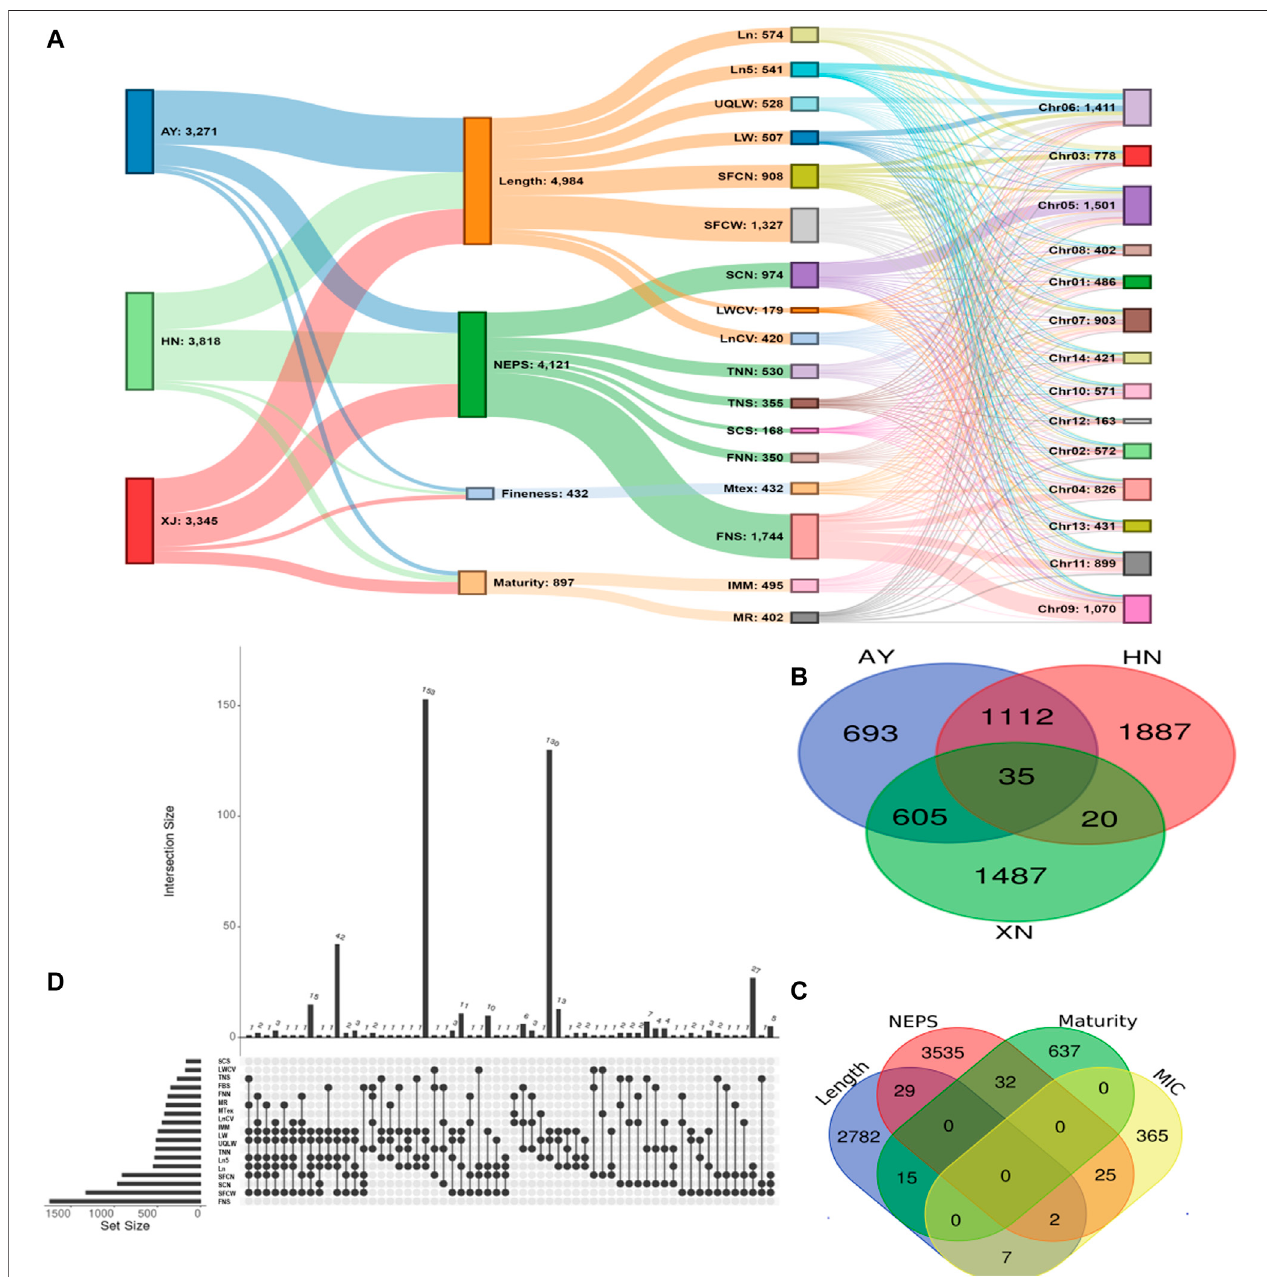
FIGURE 3 | GWAS Association Summary (A) Sankey diagram illustrating the number of signi fi cantly ( p < 0.00001) associated SNPs among evaluated environments (AY: Anyang, HN: Sanya, Hainan, XJ: Xinjiang) and single fi ber quality traits along with their distributions 13 chromosomes of Asiatic cotton (B) Venn diagram displaying the number of signi fi cantly ( p < 0.00001) associated SNPs shared among three evaluated environments (C) Venn diagram depicting number of signi fi cantly ( p < 0.00001) associated SNPs shared among four major categories of studied single fi ber quality traits of G . arboreum accessions (D) Details of signi fi cantly associated SNPs showing pleiotropism among various investigated single fi ber quality traits. All SNPs with one or more associated phenotypes are shown here.